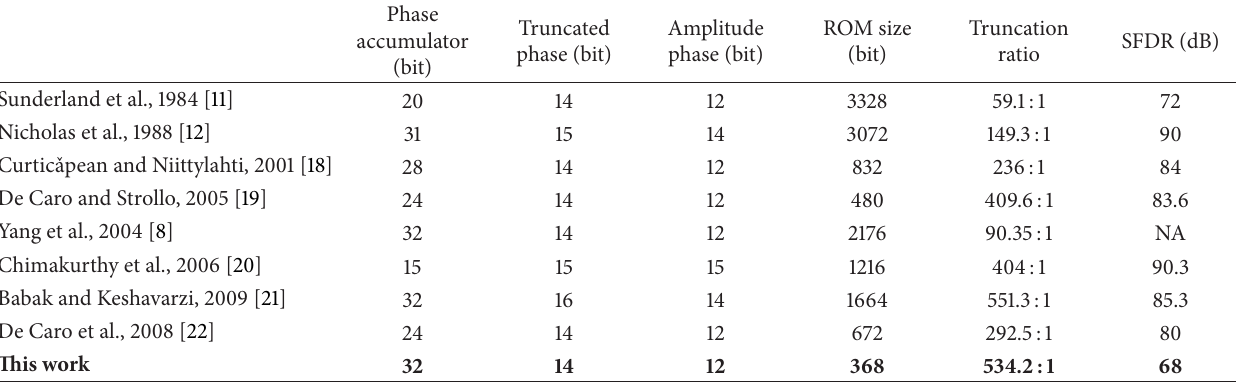
Table 1: Comparison between Rom size with previous DDFS works.